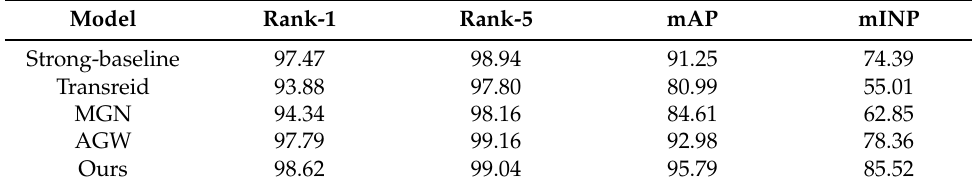
Table 5. Comparison with State-of-the-Art Re-ID methods on our dataset. Model